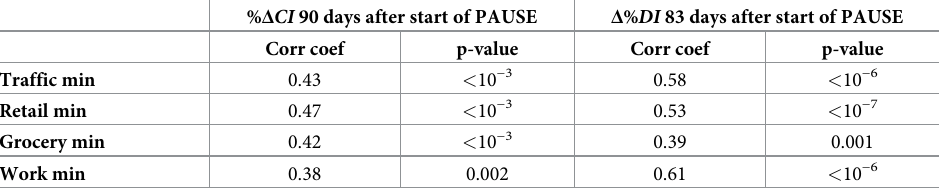
Table 3. Spearman correlations between lowest traffic/mobility levels in New York counties shorty following PAUSE, and epidemic control by the end of our study. As measures of epidemic control, we used the percent change in cumulative incidence % Δ CI and the change in smoothed daily % incidence Δ % DI , between the start of PAUSE and the end of our study. These were correlated with the lowest traffic level, as fraction of traffic baseline (top row), and with the lowest mobility levels to Retail, Grocery and Workspace (remaining three rows). The corresponding signifi- cance values are shown as separate